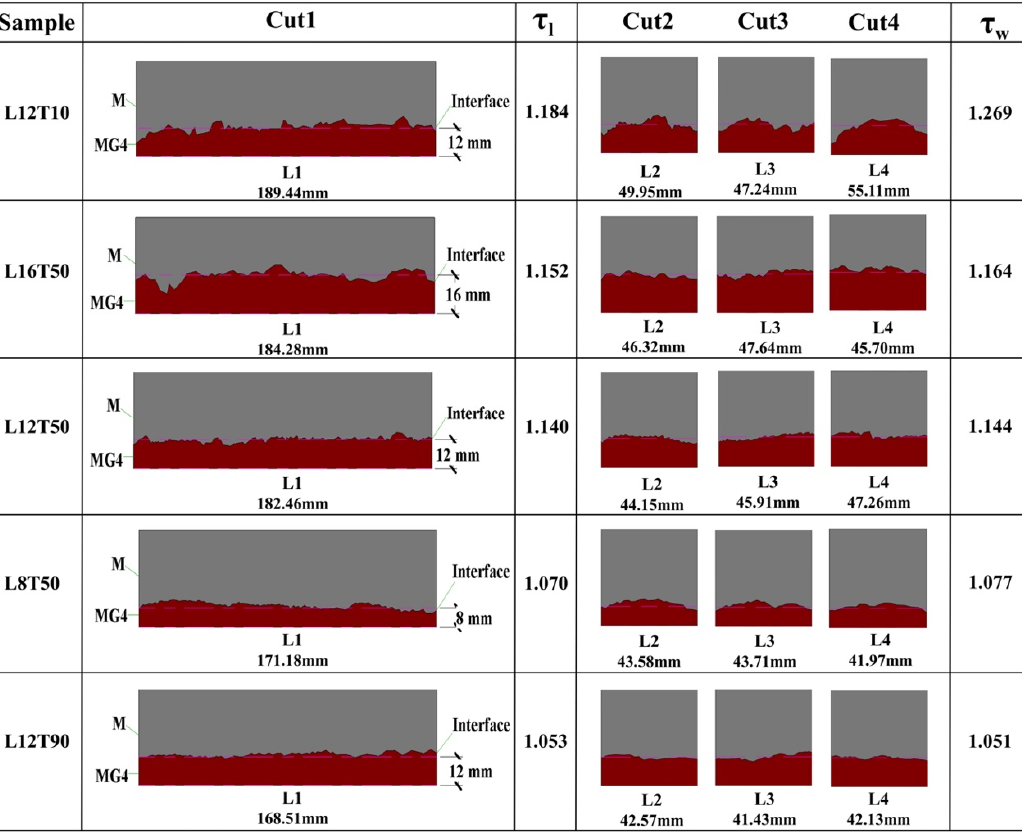
Figure 6. Digital images of each cut of specimens.